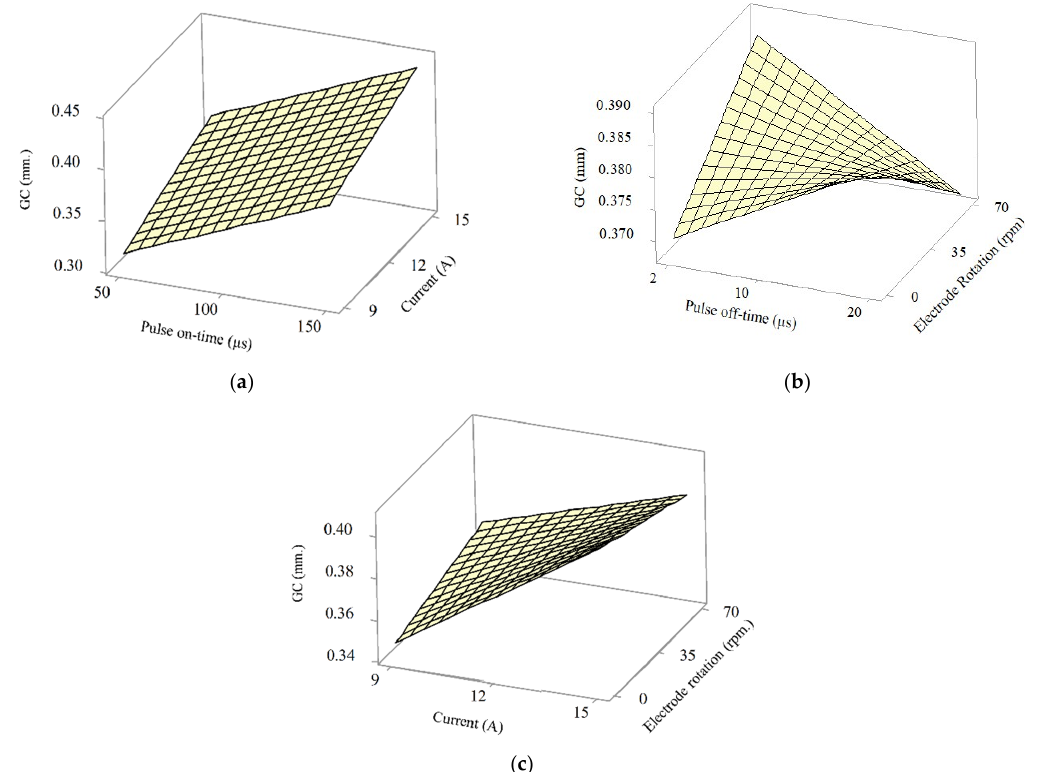
Figure 9. GC sf as a function of ( a ) pulse on-time and current, given pulse off-time = 10 µs and electrode rotation = 35 rpm, ( b ) pulse off-time and electrode rotation, given pulse on-time = 100 µs and current = 12 A, ( c ) current and electrode rotation, given pulse on-time = 100 µs, and pulse off-time = 10 µs. with multi-aperture flushing (GC mf ). GC mf was significantly correlated to pulse on-time (A), current (C), electrode rotation (D), and AB and AC interactions ( p < 0.05), with R 2 and adjusted R 2 of 78.34% and 70.46%. The reduced multiple regression model for GC mf is in Equation (11). Table 8. The ANOVA of the reduced regression model for gap clearance (GC) of EDM with multi- aperture flushing. Source Sum of Squares